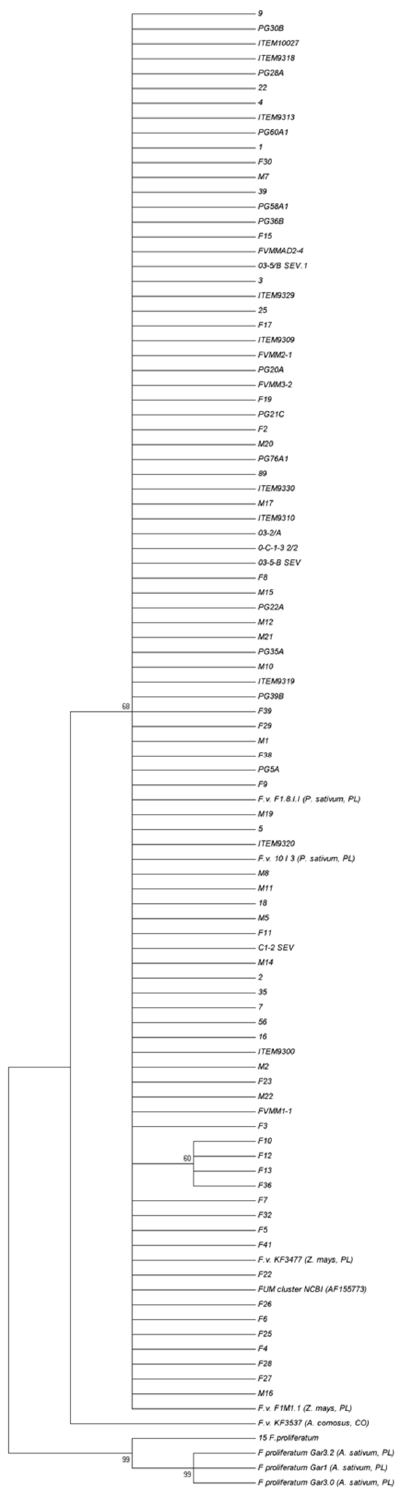
Figure 4. A most parsimonious tree calculated based on the partial FUM1 sequences of 90 Fusarium verticillioides strains isolated from Zea mays of different origins using the maximum parsimony setting, bootstrap set to 50%, and 1000 replications were done. Five reference strains isolated from Pisum sativum (F.v. F1.8.I.I; F.v. 10 I 3), Z. mays (F.v. KF3477; F.v. F1M1.1) and Ananas comosus (F.v. KF3537) were added to the analysis, as well as the NCBI GenBank-deposited FUM cluster sequences (AF155773). Four Fusarium proliferatum sequences were also included as outgroup (15; Gar3.2; Gar1; Gar3.0).